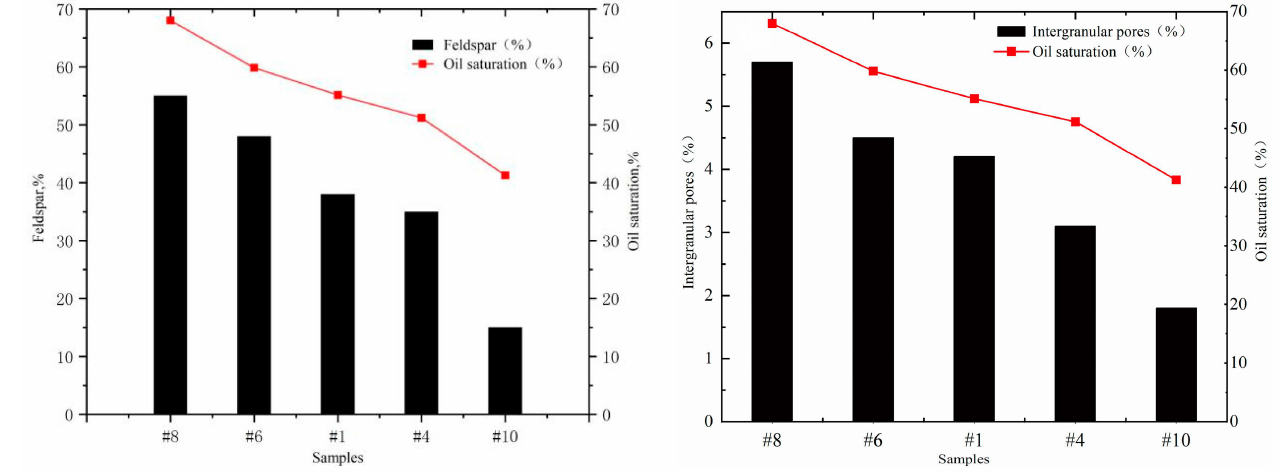
Figure 11. Relation between oil saturation and feldspar content, intergranular pore